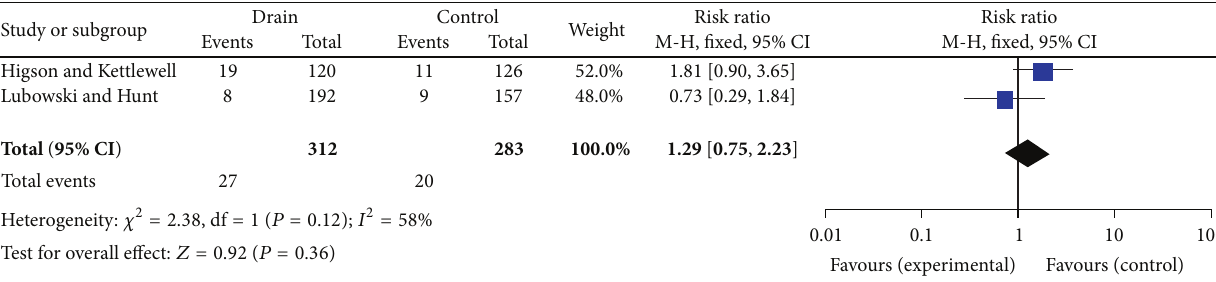
Figure 3: Forest plot data for trials including nonlaparotomy